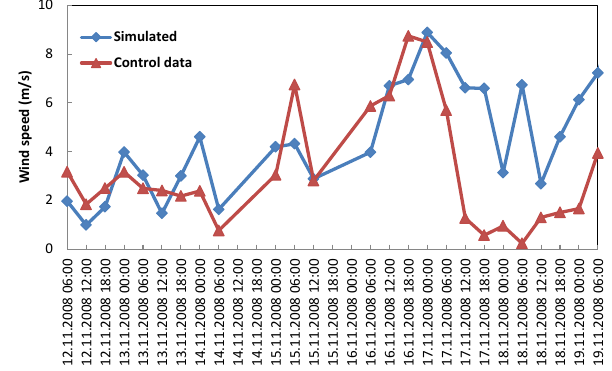
Figure 6. Comparison of best model performance (simulation 5) Fig. 6 Comparison of best model performance (simulation 5) with control data, for six-hourly 2 with control data, for 6-hourly precipitation rate prediction during precipitation rate prediction during typhoon Noul 3 typhoon Noul.